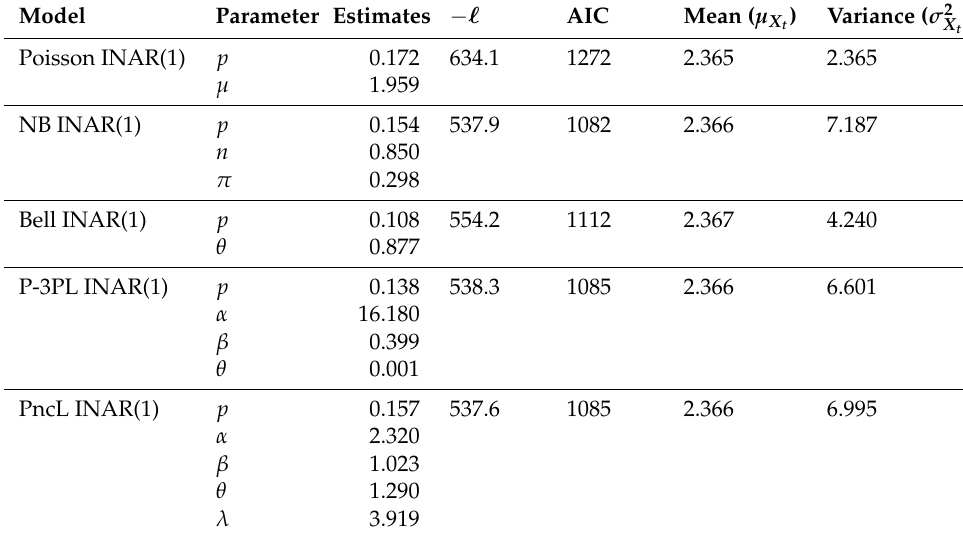
Table 8. Estimated parameters, goodness of fit statistics, fitted mean, and fitted variance of considered models for the download counts time series